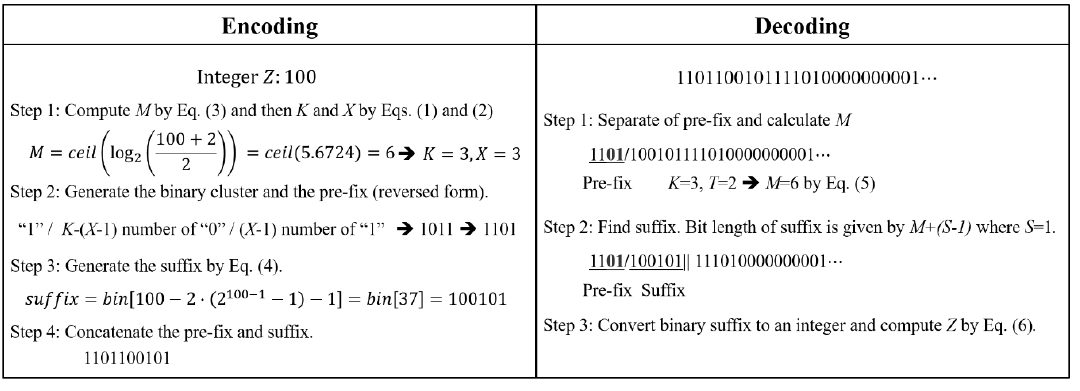
Figure 2. Encoding and decoding procedures of the proposed BL code.